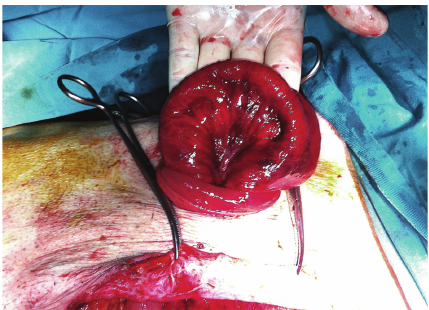
Figure 2: The view of small bowels after partial reduction at laparotomy.